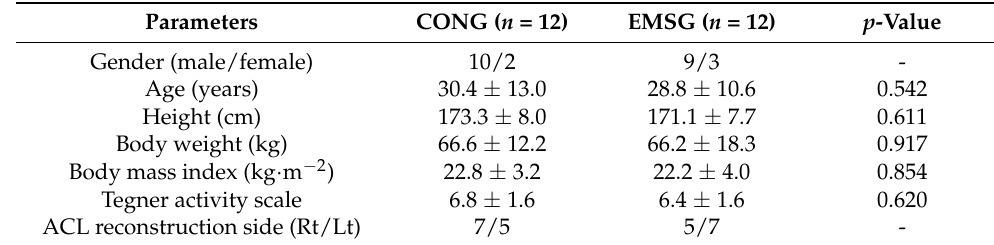
Table 1. Participants’ characteristics. Data are means (±SD).